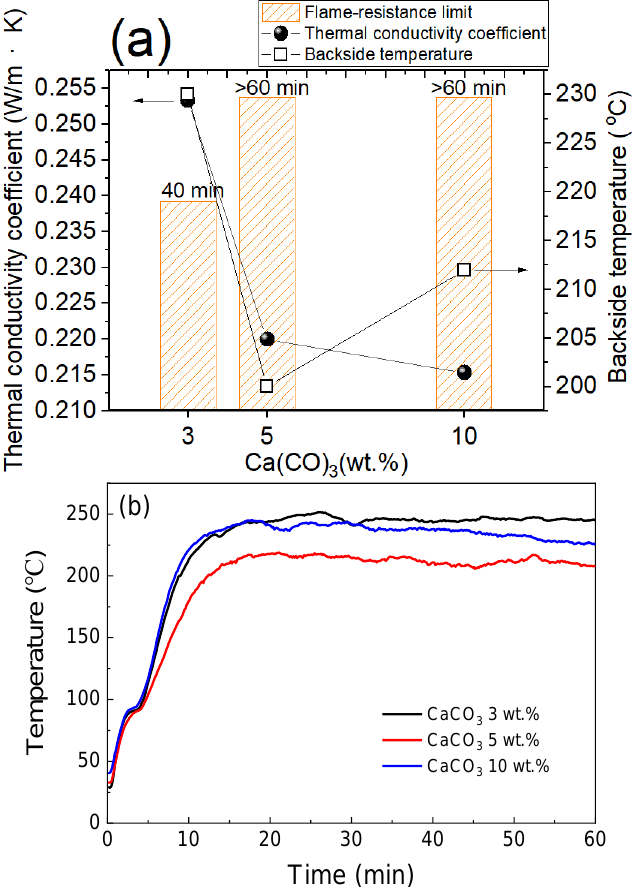
Figure 11. ( a ) Thermal conductivity, backside temperature, flame-resistance limit with respect to different contents of calcium carbonate, and ( b ) flame-resistance rating of the MKPCs (magnesia/KH 2 PO 4 molar ratio = 4; wollastonite:vermiculite = 20:10 wt.%; aluminum trihydroxide = 10 wt.%).